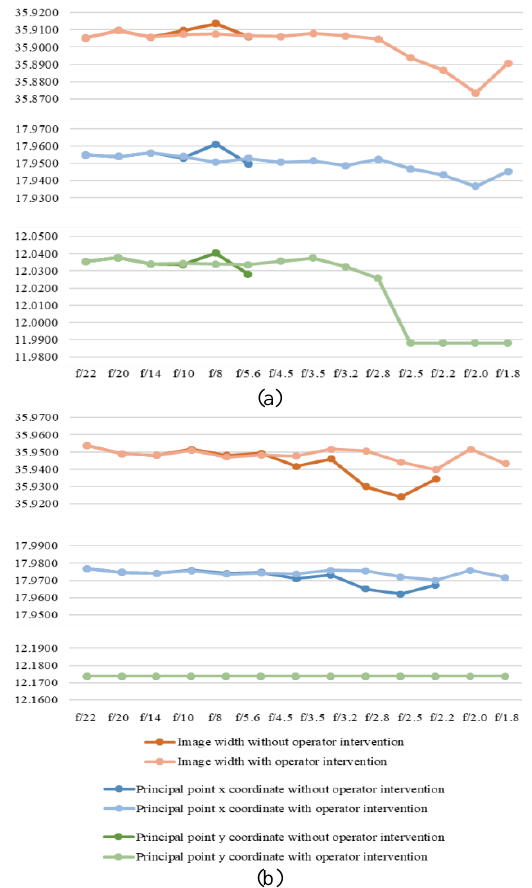
Figure 7. Results of camera calibration. Calculated image sensor width (height did not vary) and the position of the principal point (in mm). (a) DSLR camera (b) Lytro camera.